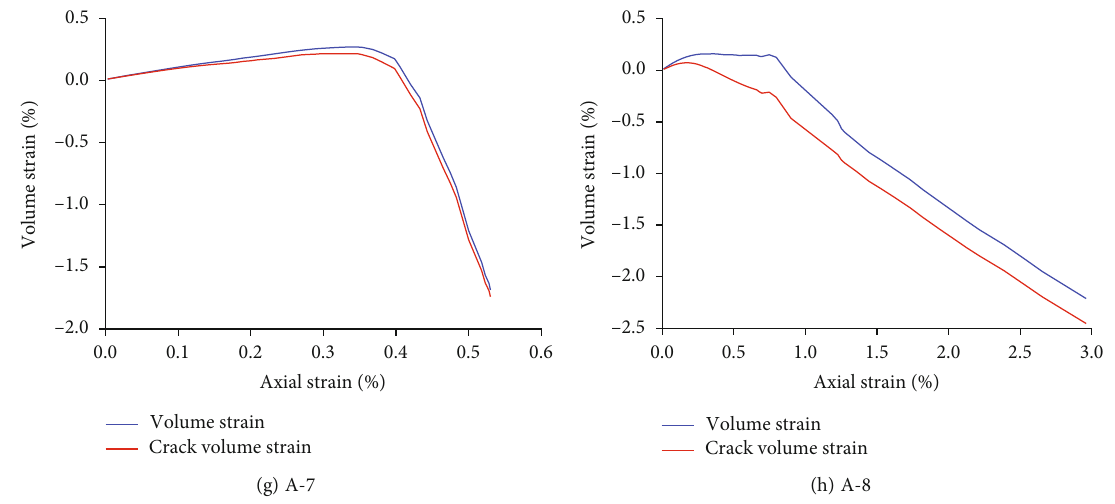
Figure 2: Volume strain-axial strain and crack volume strain-axial